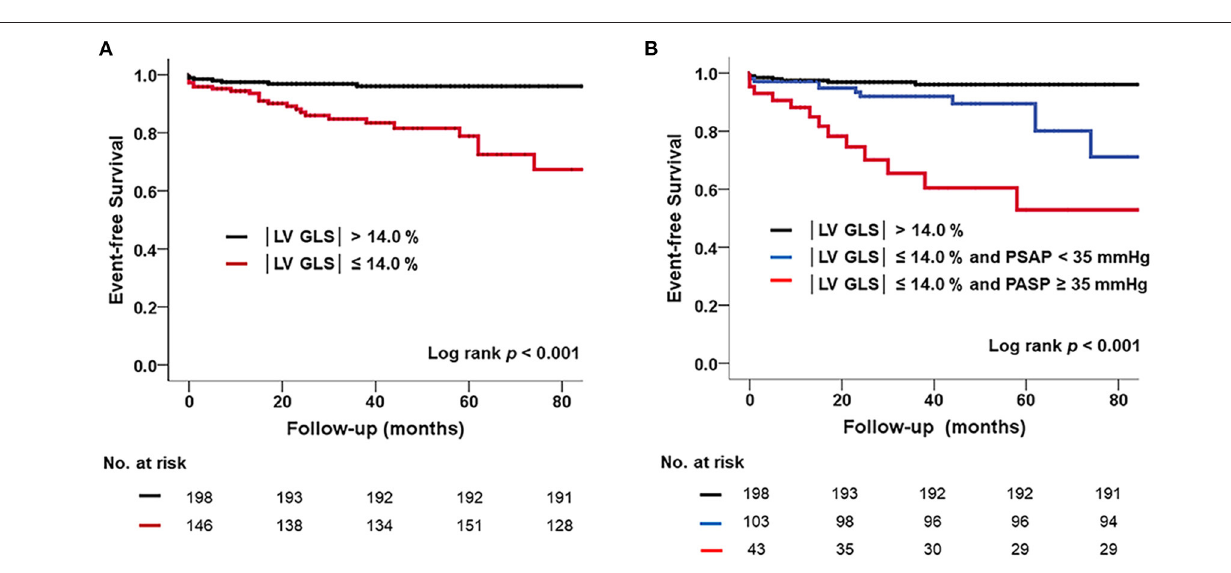
3 adjustments included the factors in Model 2 and LAVI